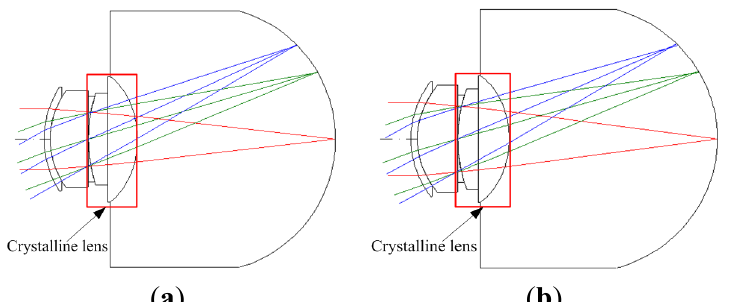
Figure 1. Two-dimensional (2D) layout diagram of the initial crystalline lens [17]. ( a ) 5 mm; ( b ) 6 mm.